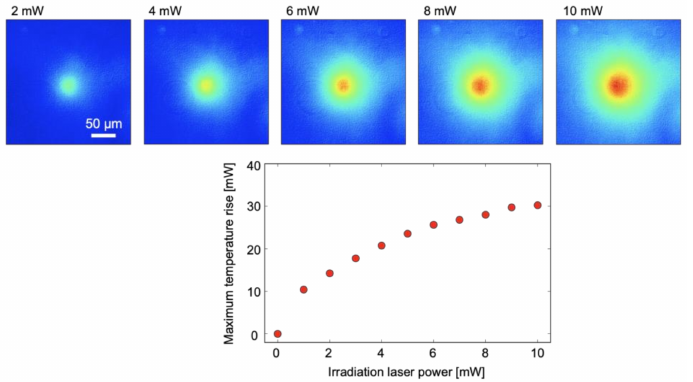
Figure 9. Temperature measurement results under local laser heating. ( upper ) Temperature fields at 2, 4, 6, 8, and 10 mW, ( lower ) maximum temperature rise at various laser